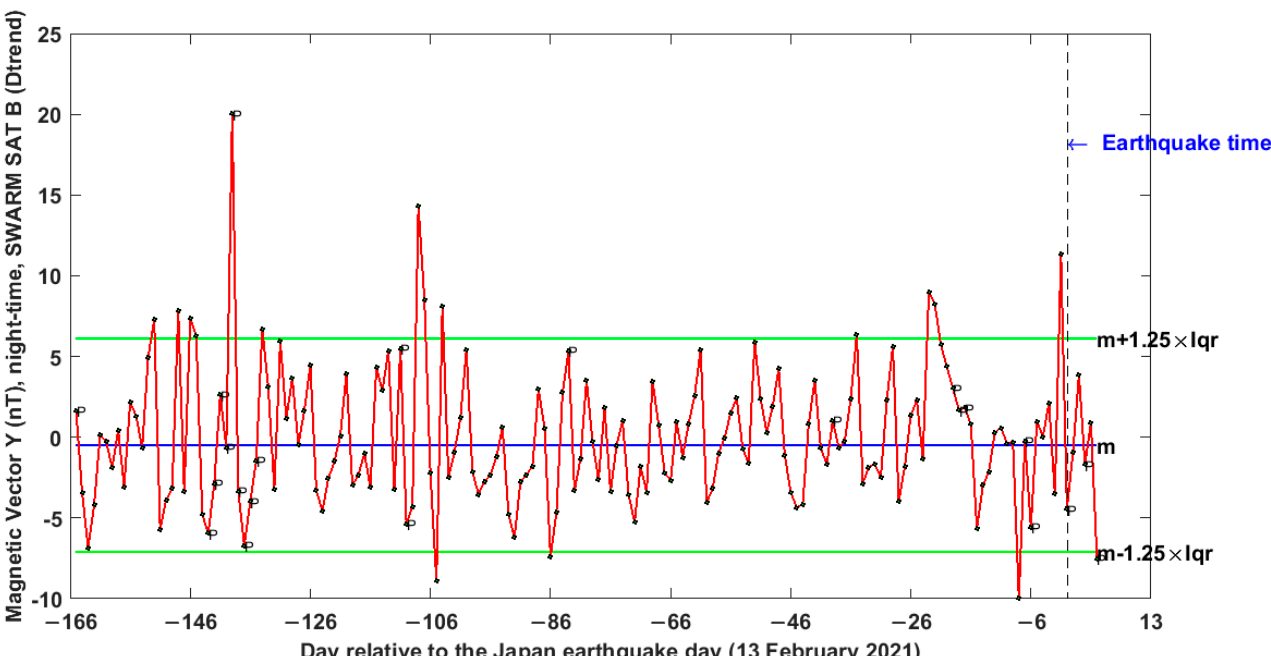
Figure 8. Results of magnetic field Y component data analysis from Swarm B for the Japan earthquake (13 February 2021) from 1 September 2020 to 18 February 2021 at night-time. The geomagnetically “perturbed” days are highlighted by a “P”.